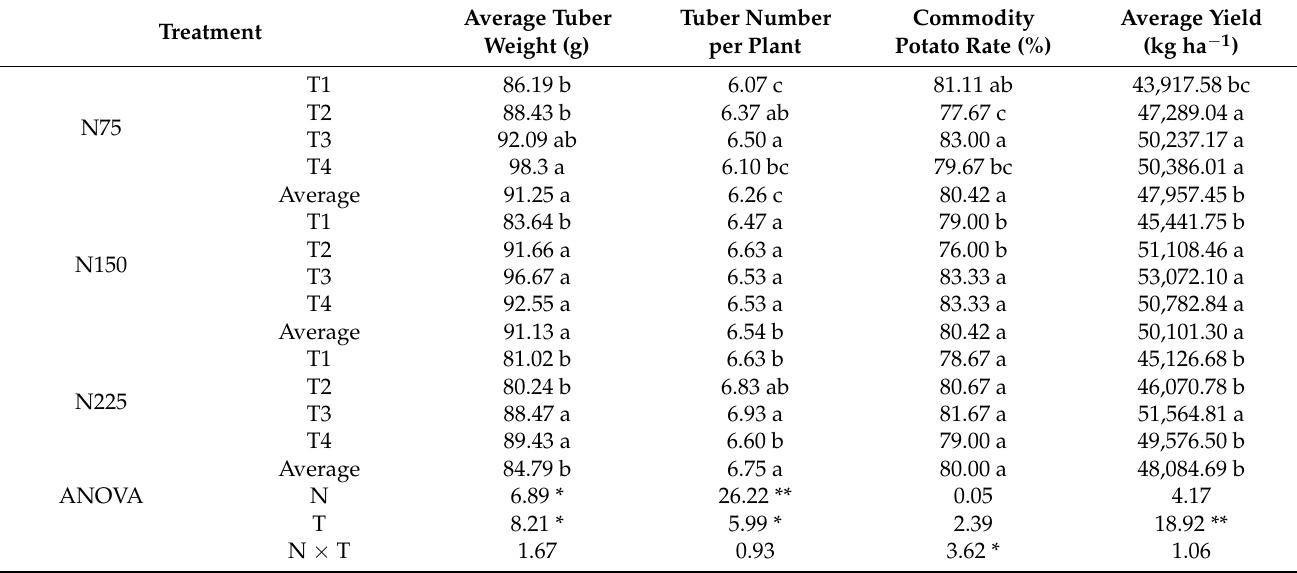
Table 3. E ff ects of di ff erent treatments on potato yield components and yield.